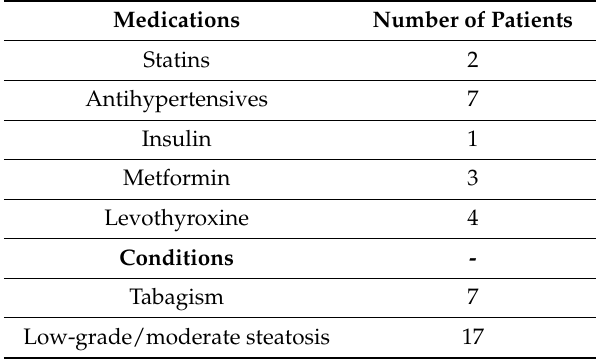
Table 1. Medications taken by the patients and medical conditions reported at baseline. Medications